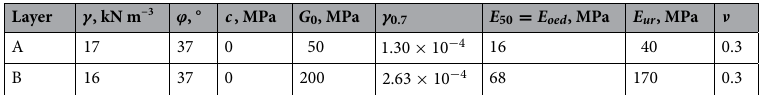
Figure 7. FEM model.